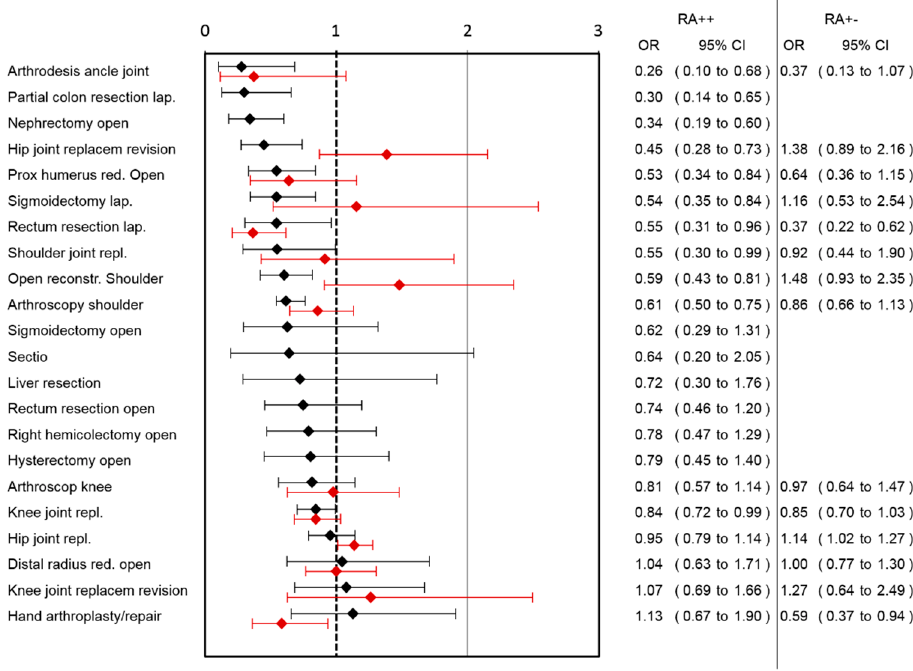
Figure 3. Association of RA with nausea in different surgical categories. Patients with continuous (RA++; black lines) or single-shot RA (RA+ − ; red lines) are compared to patients without RA (RA −− ). OR and corresponding 95% confidence intervals for both analyses are shown.